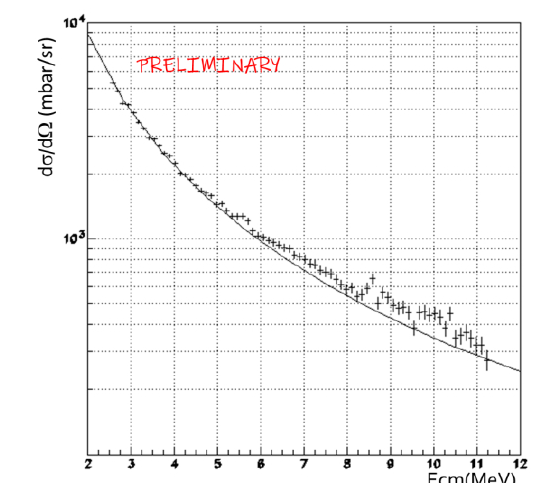
Fig. 6. Experimental centre-of-mass cross-section distribution. Absolute cross section was obtained by normalizing experimental low energy data to Rutherford cross section (solid